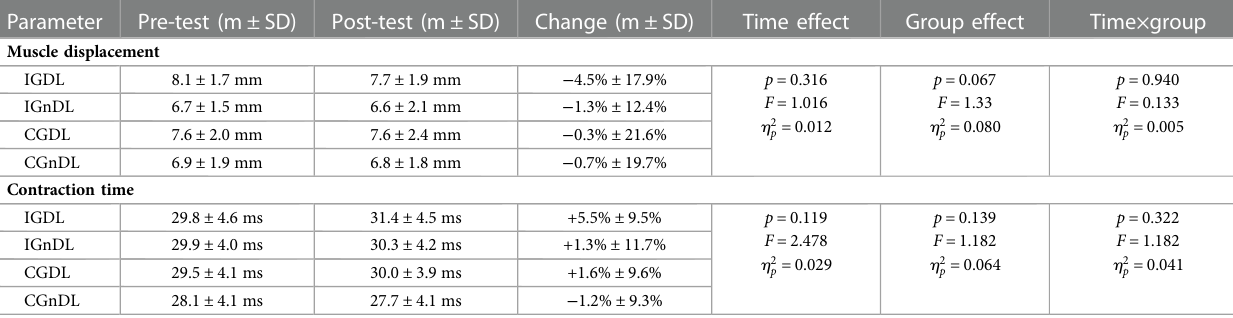
these parameters.